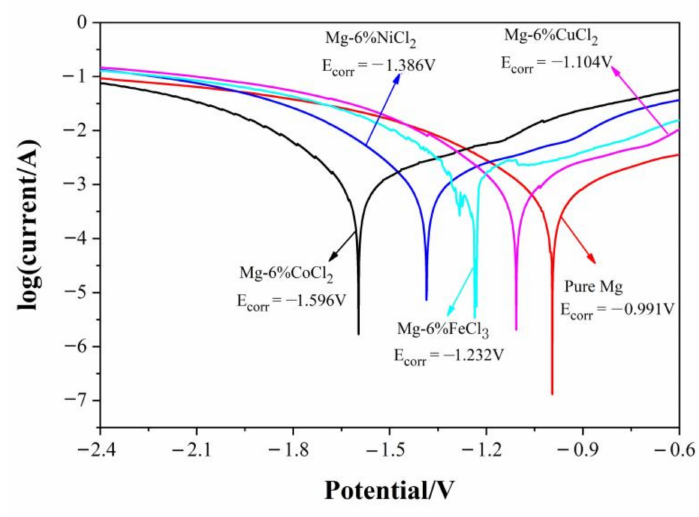
Figure 8. Tafel curves of the ball-milled Mg-chloride.